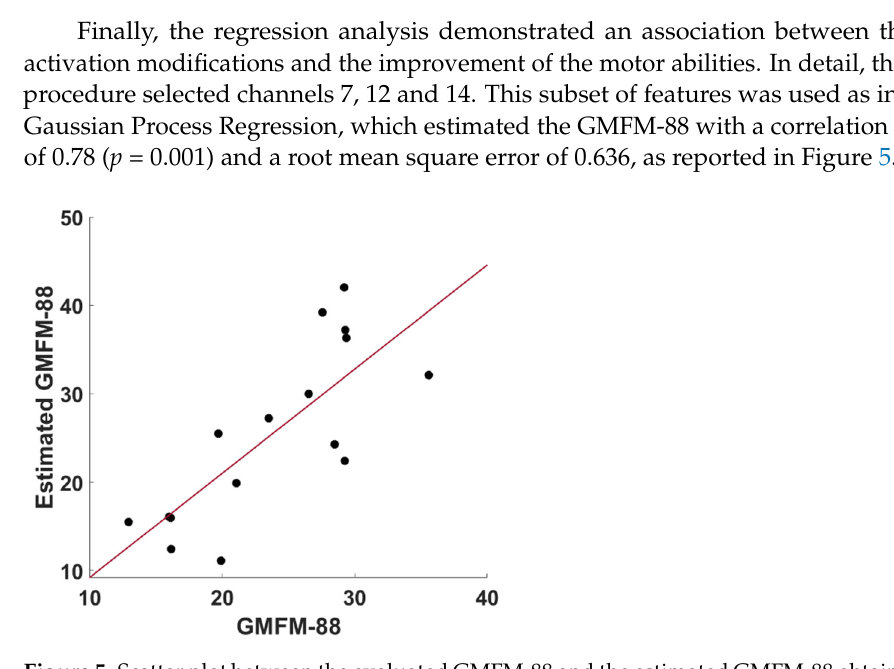
Figure 5. Scatter plot between the evaluated GMFM-88 and the estimated GMFM-88 obtained through a leave-one-subject-out cross-validated Gaussian Process Regression from fNIRS β -values selected employing a Wrapper procedure.